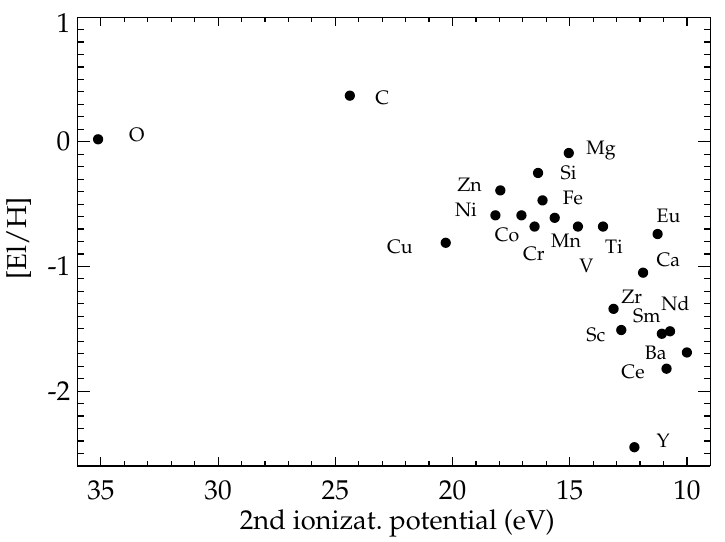
Fig. 5. Abundances [El/H] vs. the second ionization potential for R Sct.